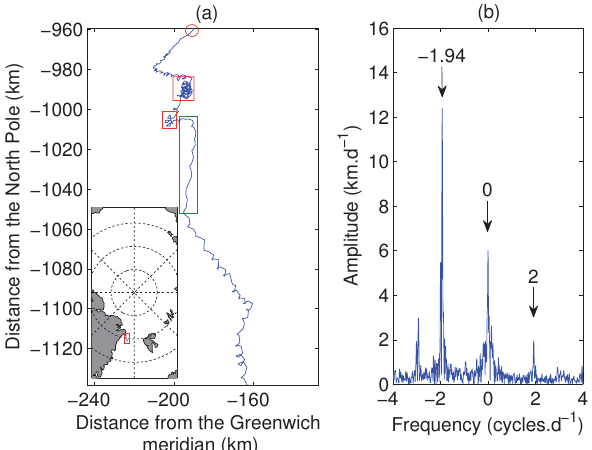
Fig. 5. (a) 1month sample of the trajectory of buoy 12825 (20 April to 21 May 1992). The location of the buoy within the Arctic Basin is indicated by the red box in the inset of Fig. 5a. (b) Fourier spectrum of the buoy velocity. The velocity is computed following Eq. (3) with 1t =